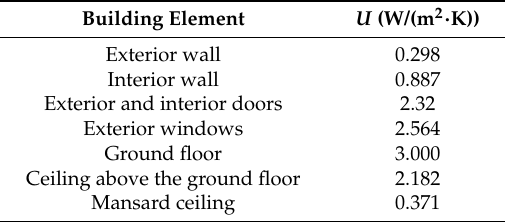
Table 2. Overall heat transfer coefficient values for building elements.